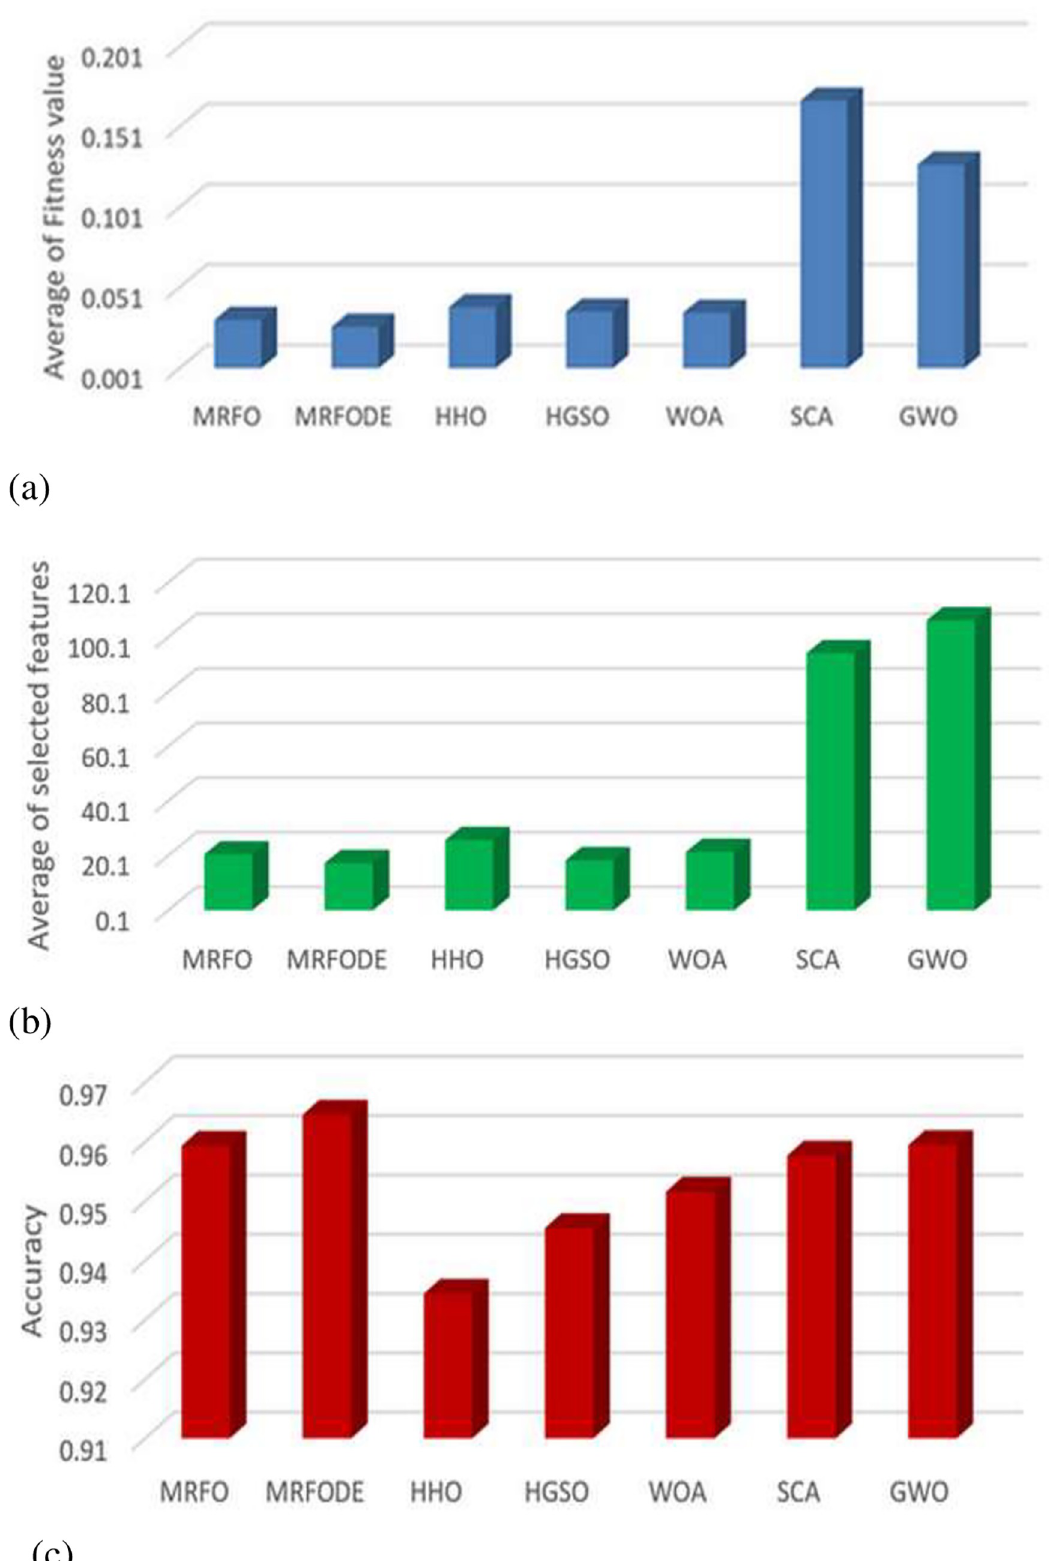
Fig 4. Average of comparison results between algorithm over (a) accuracy, (b) a number of selected features, and (c) fitness value.